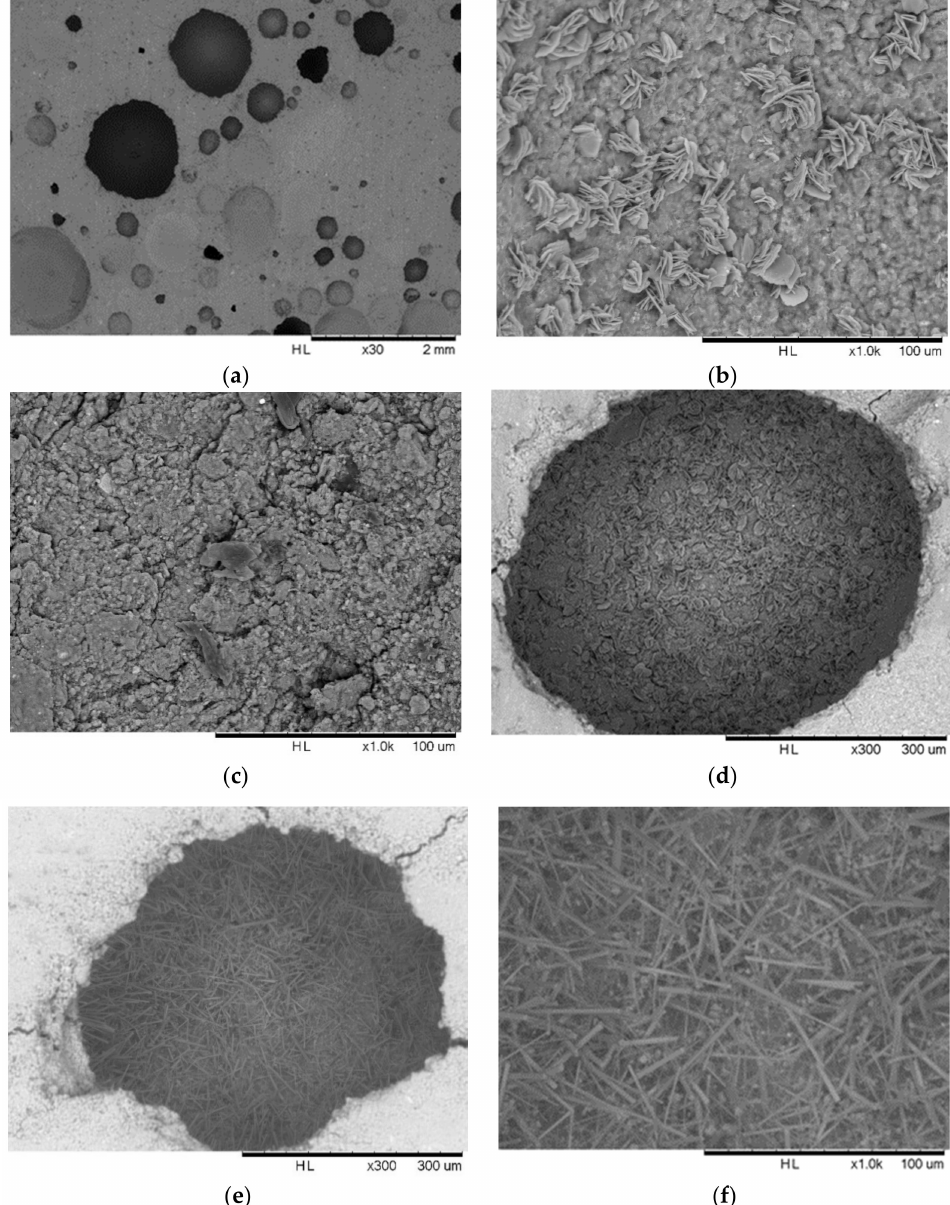
Figure 11. Micro-morphology of specimens of di ff erent mix designs. ( a ) 50% water environment × 30; ( b ) 50% water environment × 1000; ( c ) 80% water environment × 1000; ( d ) 50% water environment × 300; ( e ) 50%, 10% sodium sulphate × 300; ( f ) 50%, 10% sodium sulphate ×